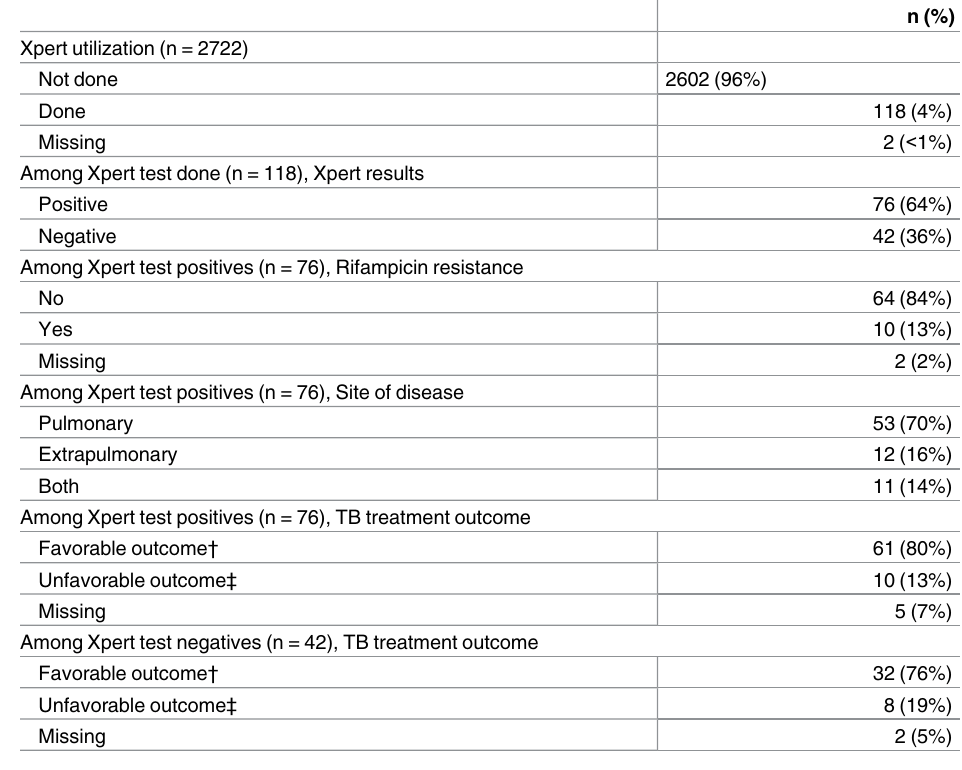
Table 4. Xpert MTB/RIF utilization and outcomes among 2722 adult patients.